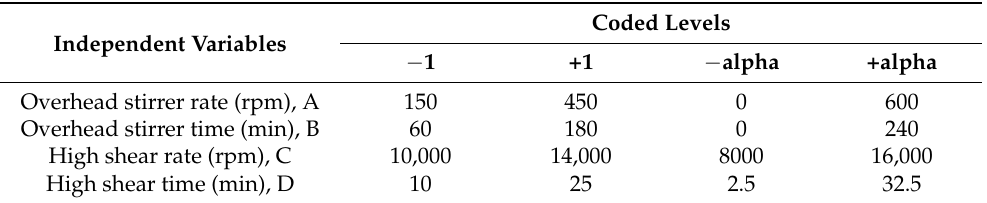
Table 1. The CCD coded independent variables used in RSM